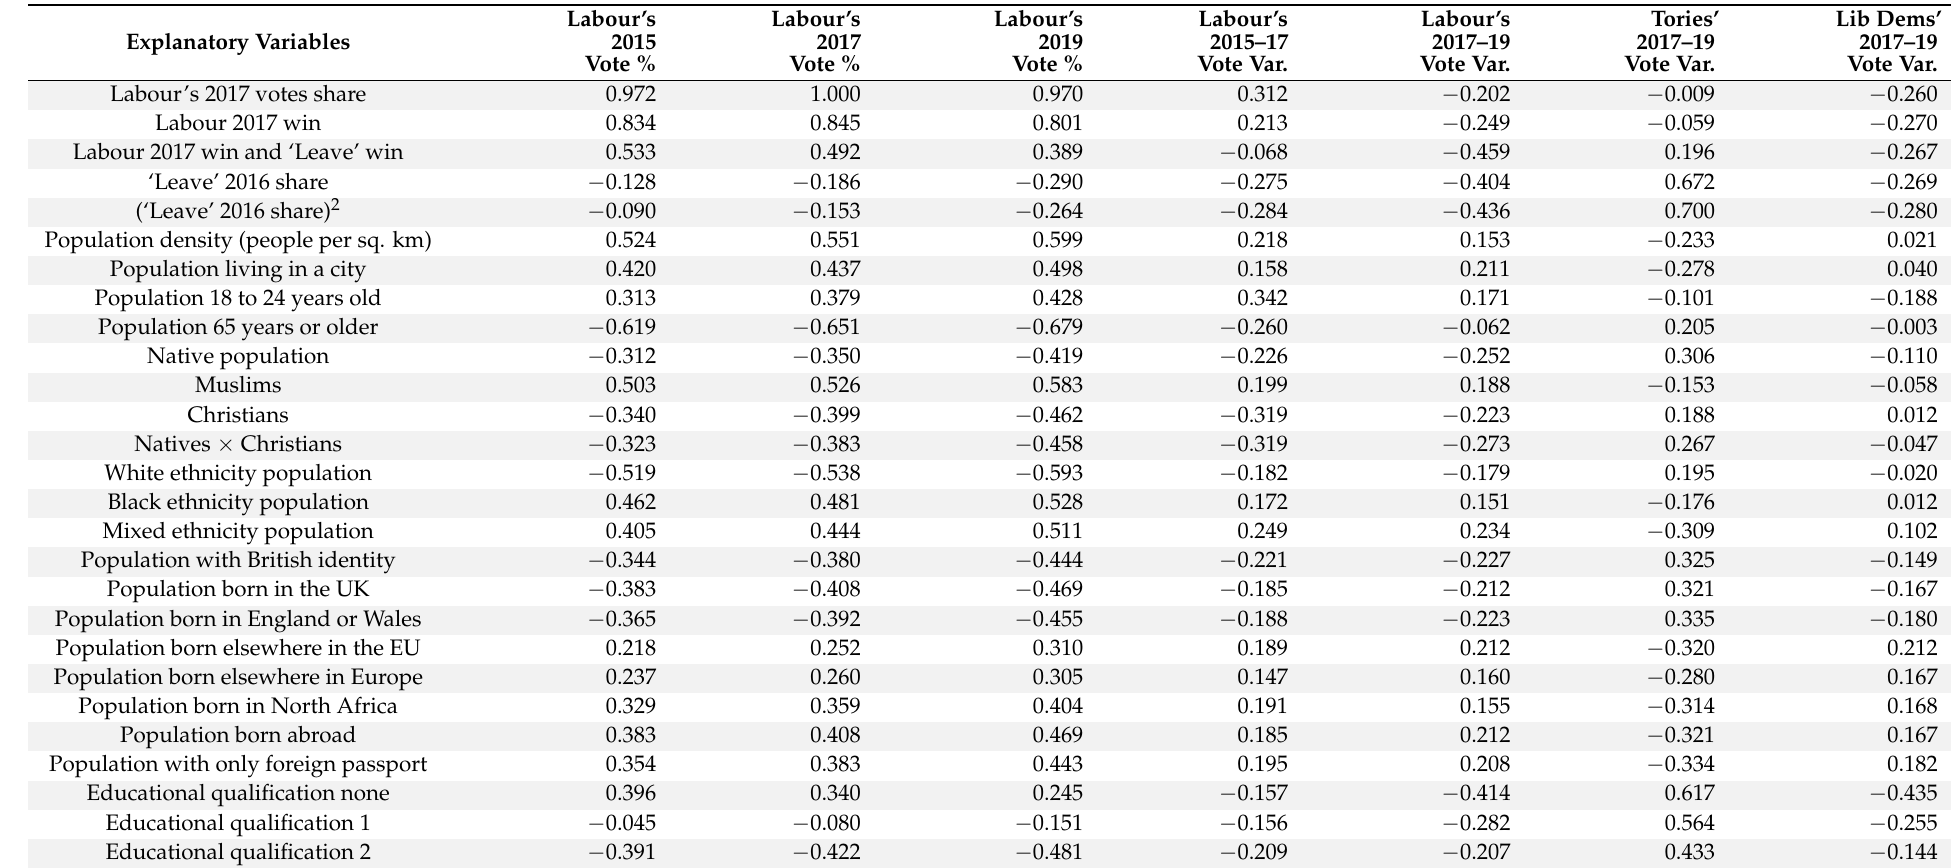
Table A1. Pearson correlations between Labour’s 2015–2017–2019 vote, 2017–2019 vote variation in, respectively, the Labour, Conservative and Liberal